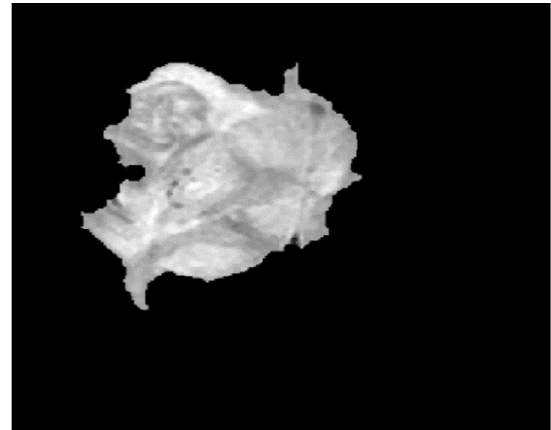
Fig. 5 The result of tumor